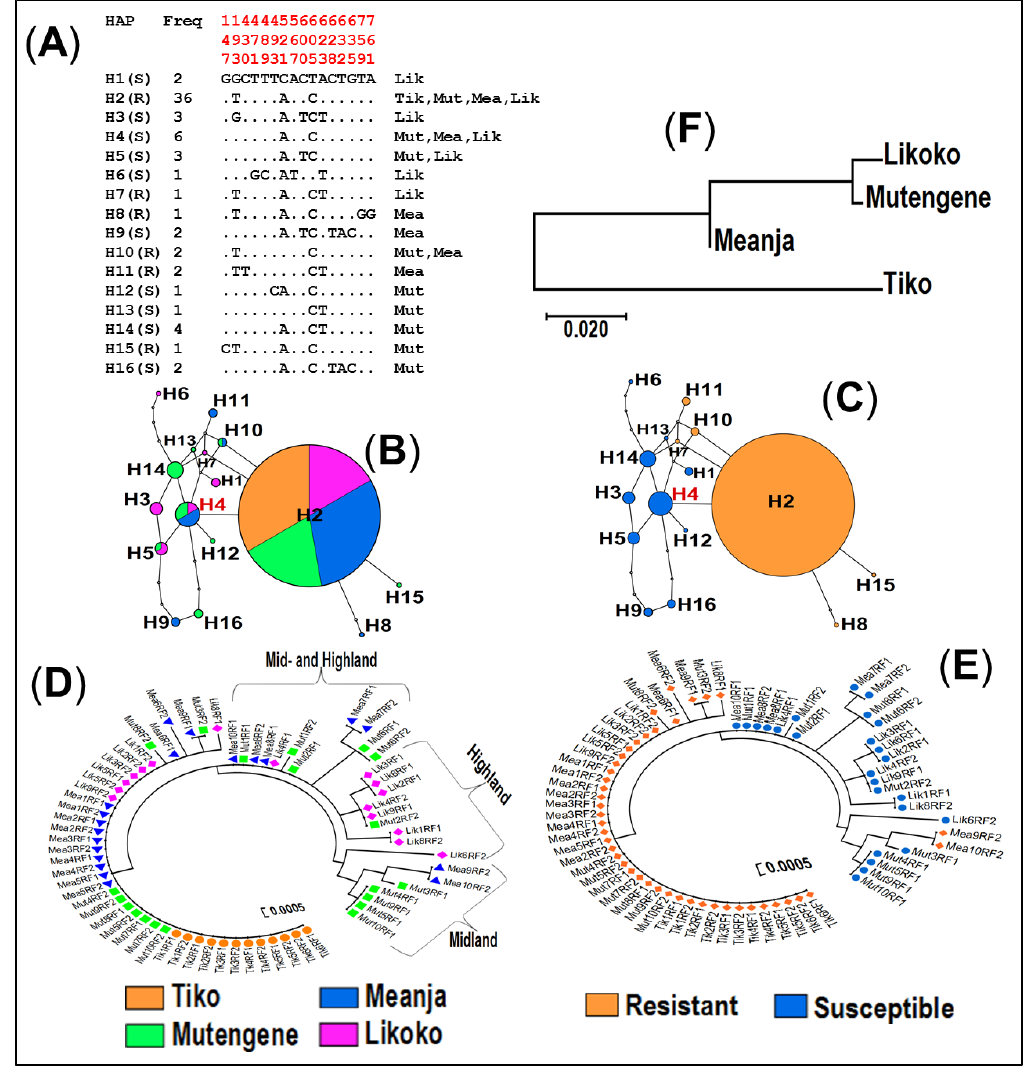
Figure 6. Genetic diversity and polymorphism patterns of the GABA-receptor gene across the Mount Cameroon area. ( A ) Haplotype diversity patterns of a 1006 bp fragment of the GABA-receptor gene in Tiko (Tik), Mutengene (Mut), Meanja (Mea) and Likoko (Lik); H = haplotype; R = resistant; S = susceptible; polymorphic sites are in red. TCS haplotype networks showing a high polymorphism of the GSTe2 gene in An. funestus s.s with a reduced number of mutational steps between haplotypes with respect to localities ( B ) and allelic profiles ( C ); haplotypes are presented in circular shape scaled to reflect their respective frequencies; ancestral haplotype is in red. Maximum likelihood phylogenetic trees of Rdl -DNA sequences among localities ( D ) and allelic profiles ( E ) showing a marked separation between A296 and 296S allele carriers. ( F ) Neighbour-joining tree of the genetic distances showing an apparent genetic relatedness associated with the altitude along Mount Cameroon with Tiko being genetically differentiated from other localities. Table 2. Genetic variability parameters of Rdl full mutation.